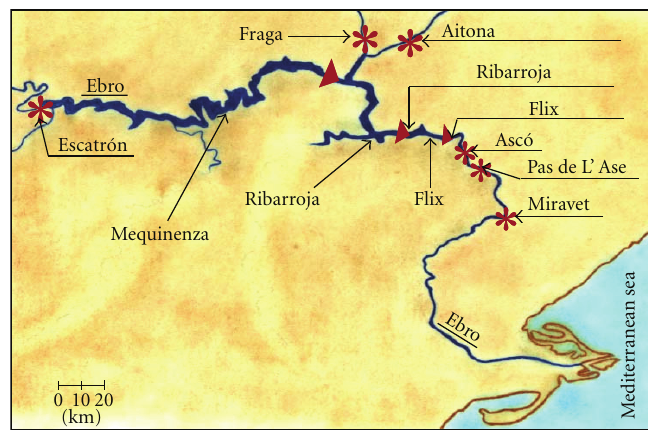
Figure 1: Station locations at the Ebro River, Spain.